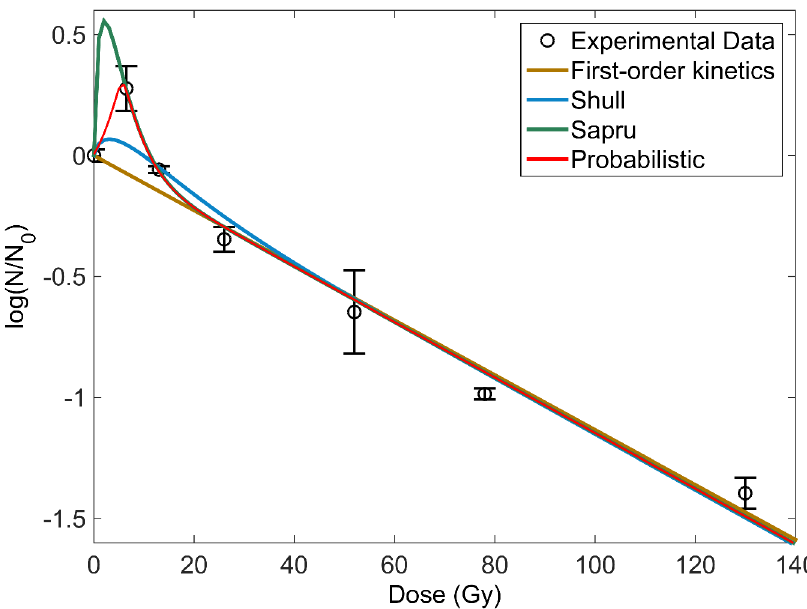
Fig 3. Comparison of fit for first-order kinetics model, Shull model, Sapru model and Probabilistic model. Irradiationwas conductedon Bacilluspumilus spores with X-ray cut-off energy of 50keV.